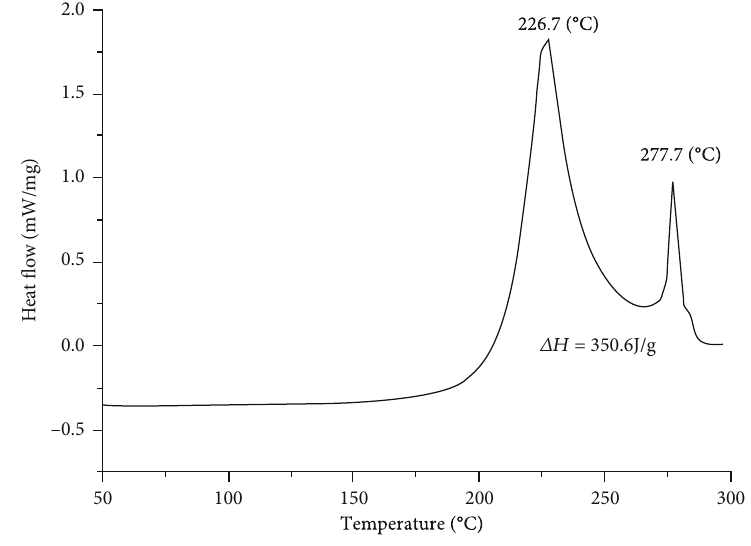
Figure 1: Dynamic DSC curve of MDPES-2 resin.